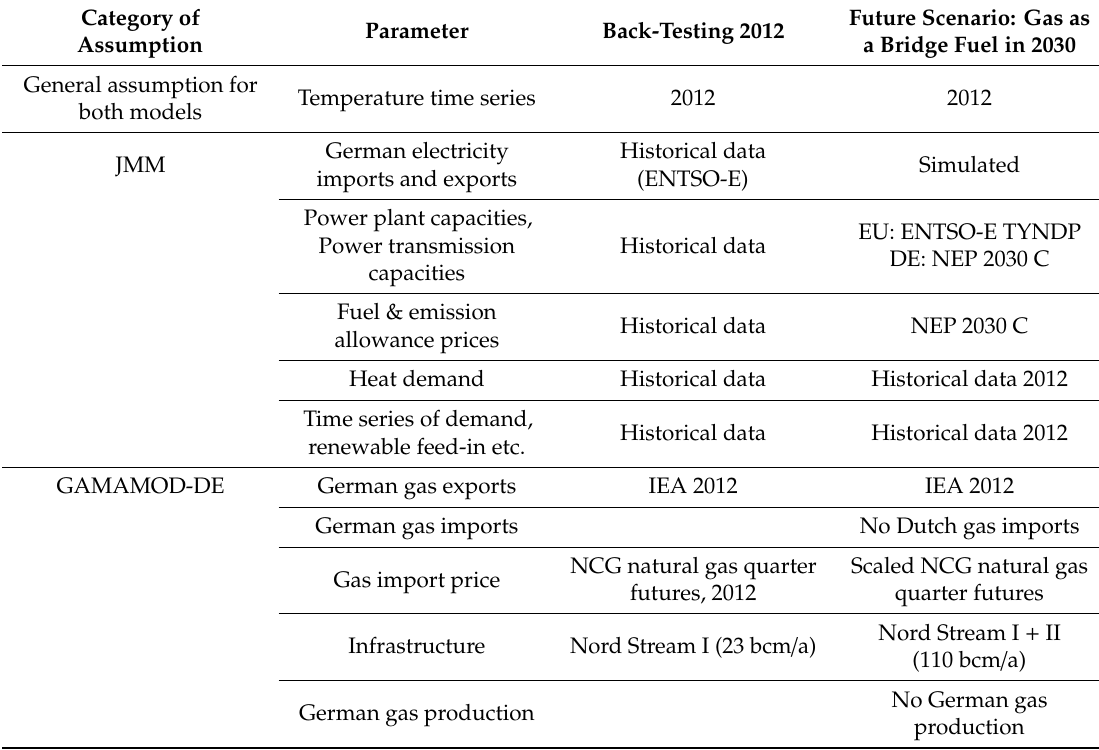
Table 1. Data assumptions for 2012 and